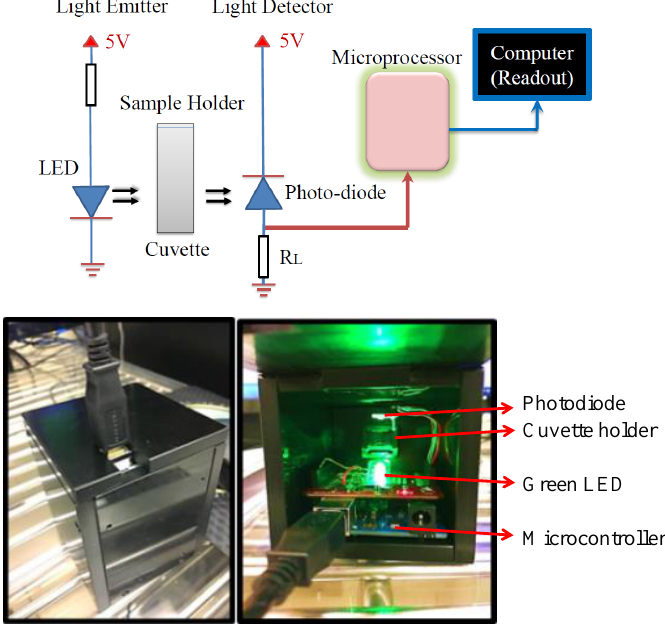
Figure 1. ( a ) The schematic of the experimental setup used to calibrate and test glycated hemoglobin concentration. ( b ) Snapshots of the designed